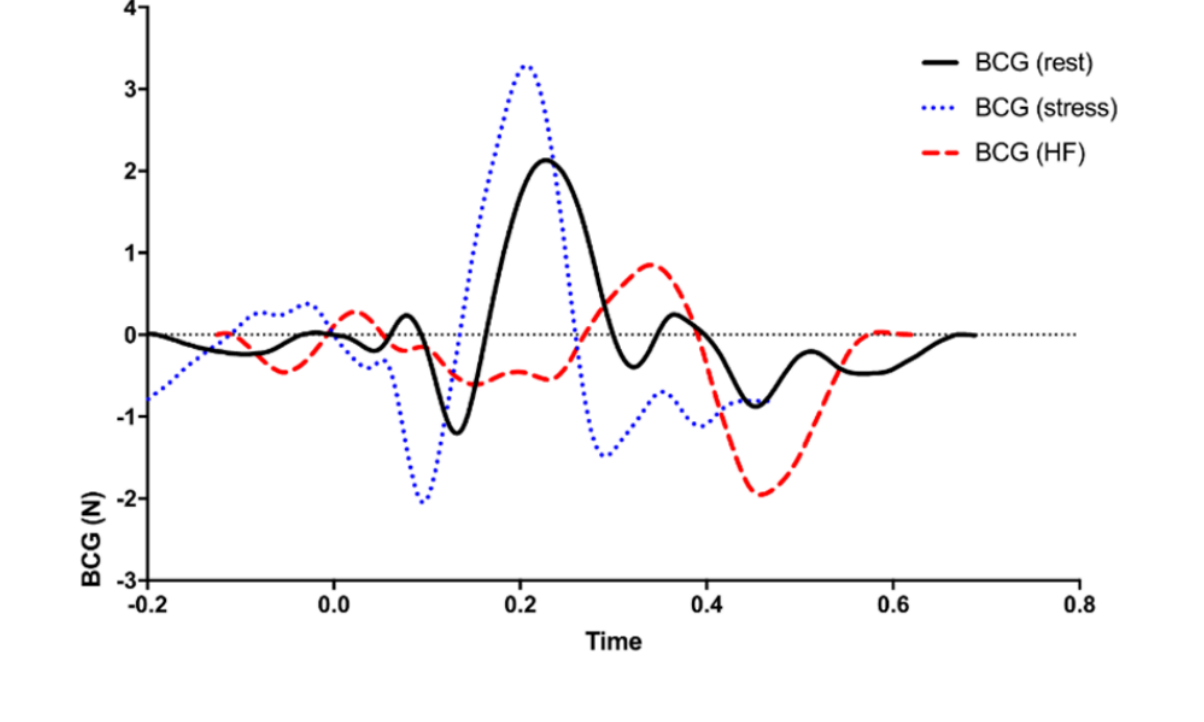
Figure 4. The ballistocardiogram (BCG) amplitude and timing vary greatly based on the cardiovascular state. Heart failure (HF) BCG waveforms have a much smaller amplitude when compared with the normal BCG waveform at rest and poststress.